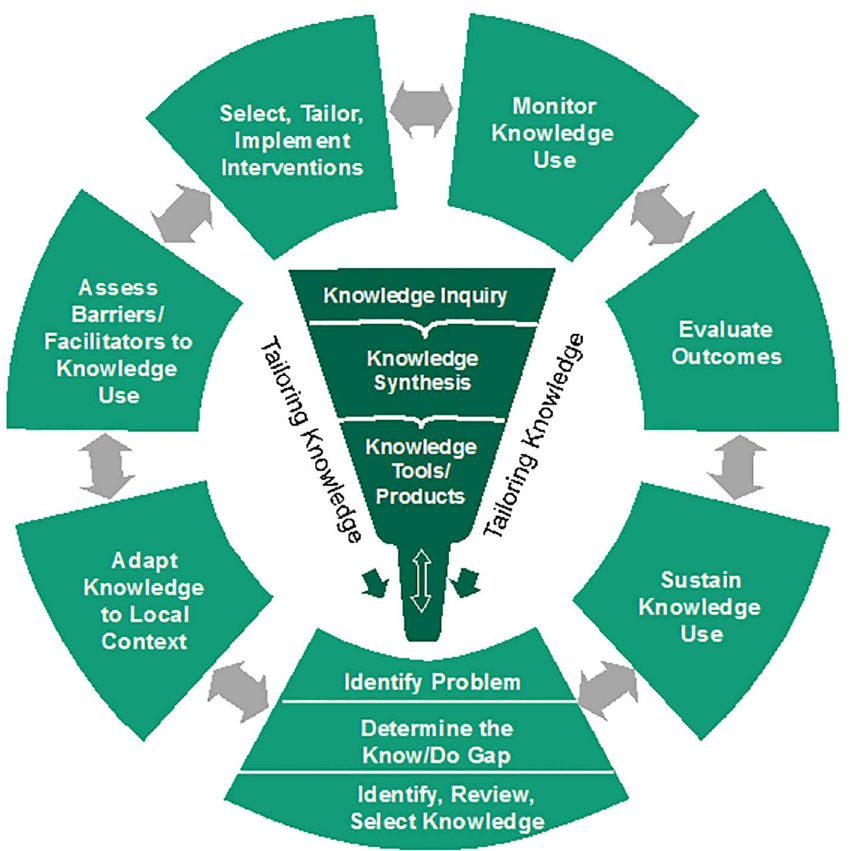
Fig 1. Knowledge-to-Action Cycle (Reproduced with permission from[38]). Reprintedfrom Straus SE, Tetroe J, Graham I. Knowledge translation in health care: moving from evidenceto practice. 2nd ed. BMJ Books, Wiley, 2013. under a CC BY license, with permission from Wiley, originalcopyright